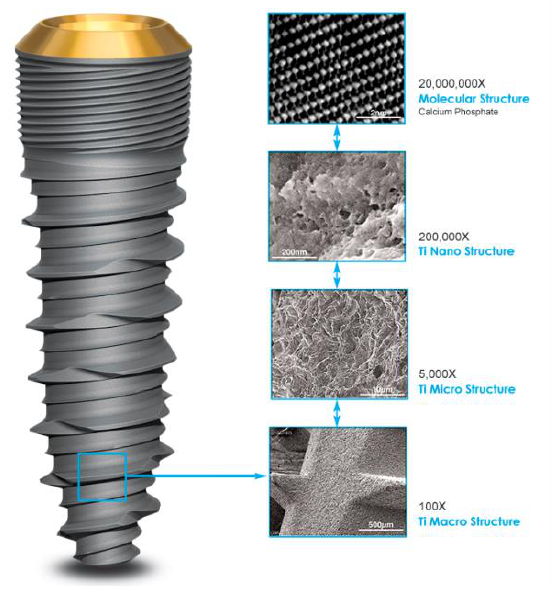
Figure 3. Ossean ® implant surface [30].